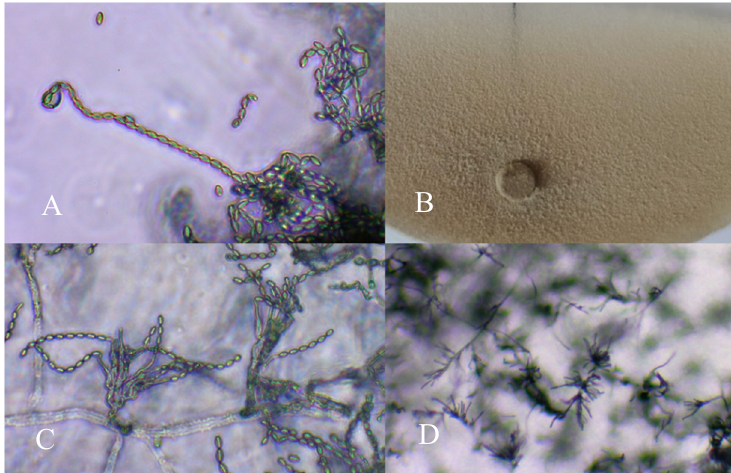
Figure 1. Conidiophore of Paecilomyces variotii ( A : 400×; C : 200×; D : 100×) and an aspect of colony morphology ( B ) in the potato dextrose agar (PDA) medium.